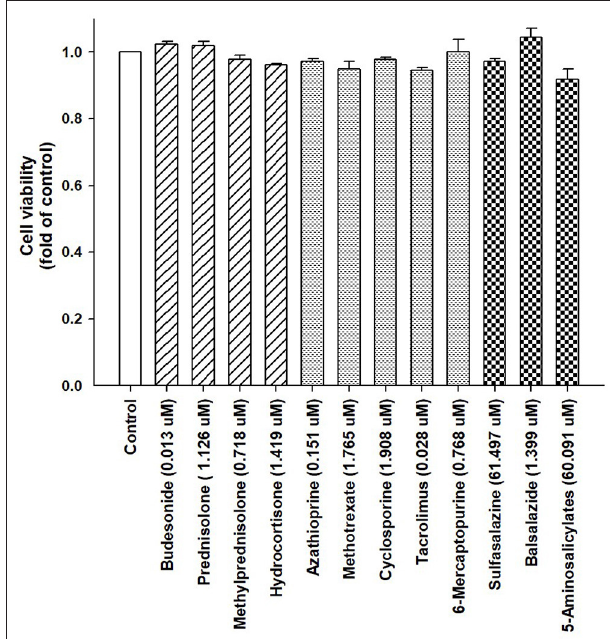
FIGURE 2 | Viability of HepaRG cells following exposure to IBD medications. HepaRG cells were exposed to corticosteroids (budesonide, prednisolone, methylprednisolone, and hydrocortisone), immunomodulators (azathioprine, methotrexate, cyclosporine, tacrolimus, and 6-mercaptopurine), and aminosalicylates (sulfasalazine, balsalazide, and 5-aminosalicylate) for 48h. Cell viability was monitored by cellular acid phosphatase activity using p -nitrophenylphosphate as a substrate. The data are shown as the mean ± SE (error bars) ( n =